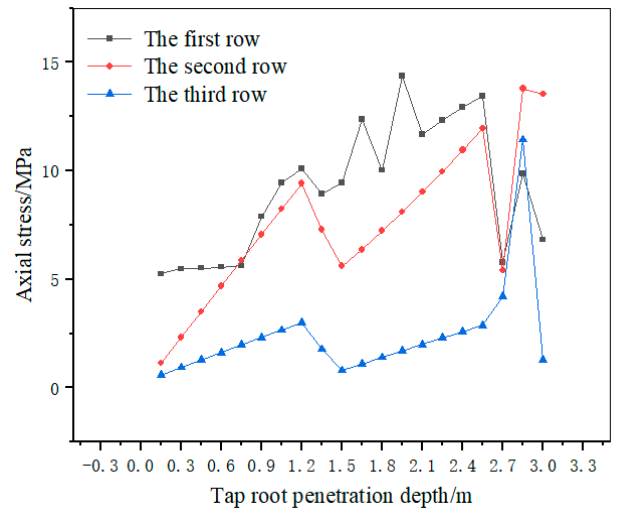
Figure 8. The first to third rows tap roots stress.